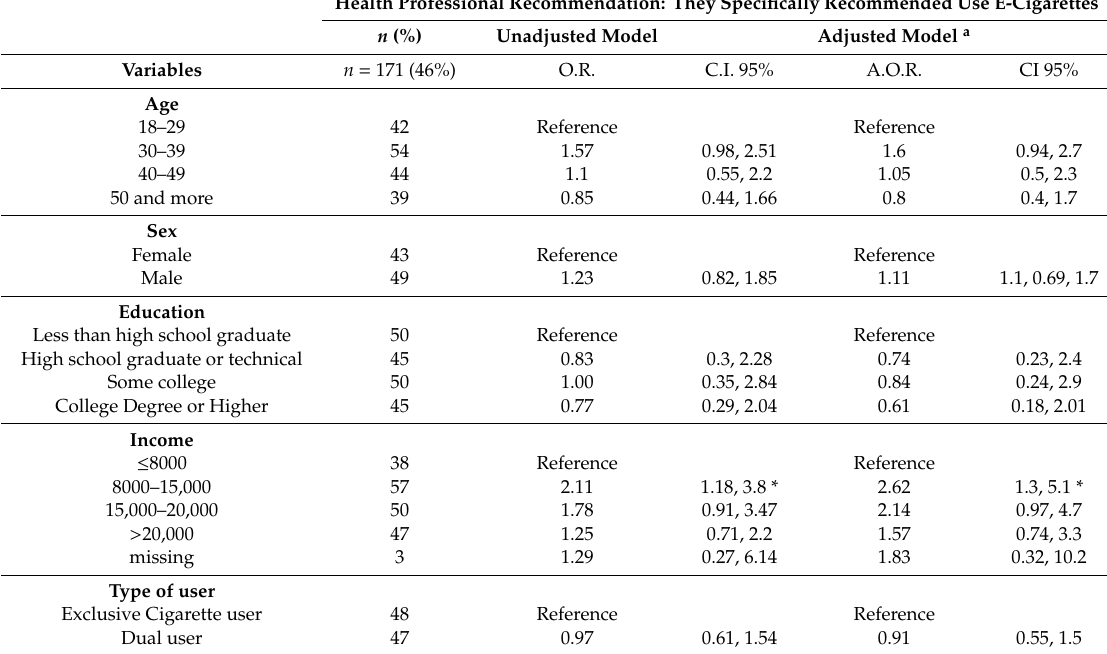
Table 4. Factors associated with physicians recommending e-cigarettes to adult smokers (among those who discussed e-cigarettes) aged 18 to 71, living in Mexico 2018–2019, ( n =